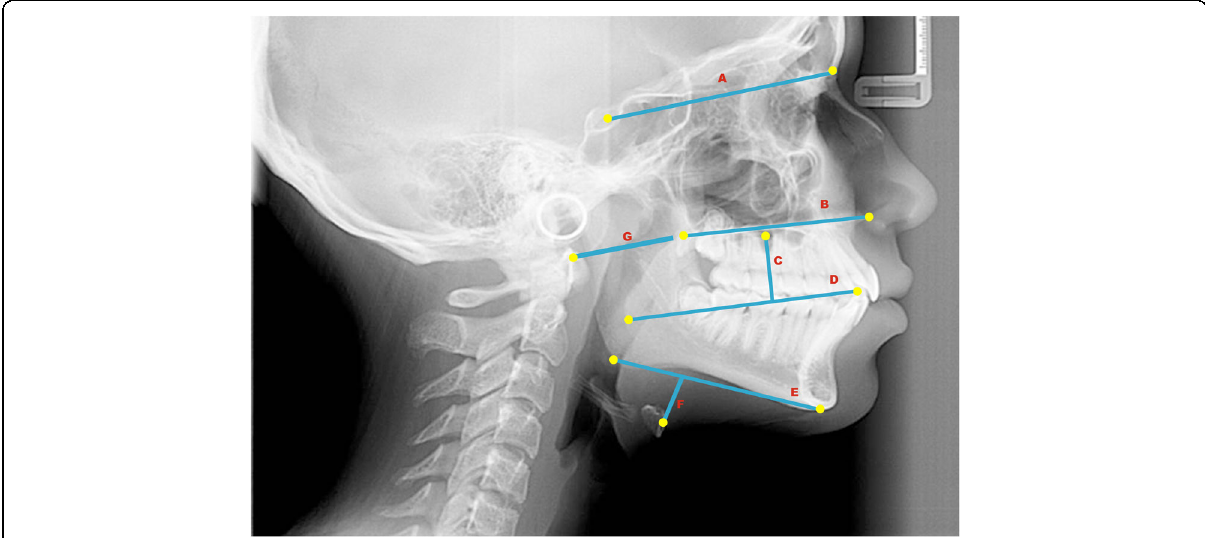
Fig. 5 Cephalometric planes (cranial base, maxilla, mandibulla, nasopharynx and hyoid-mandibular plane